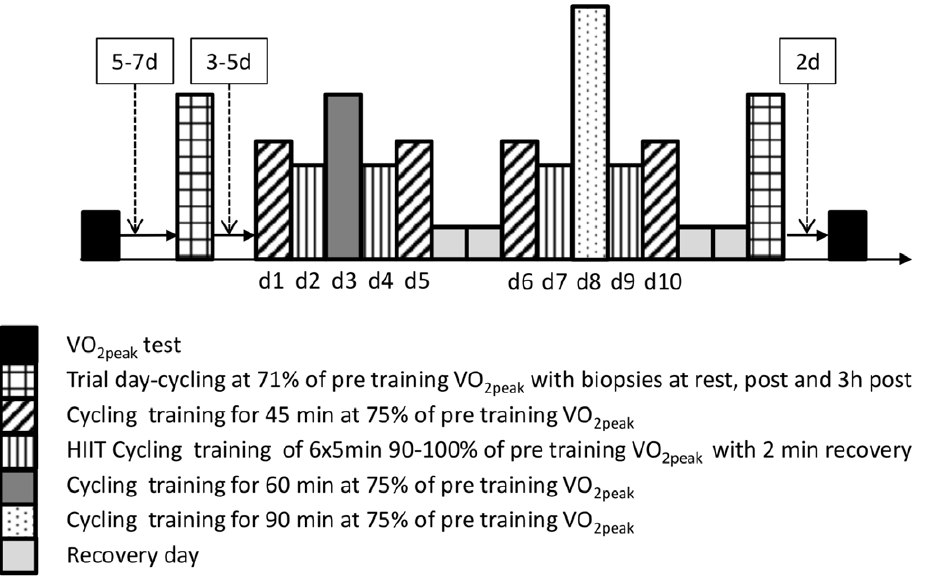
Figure 1. Schema of the study design showing the 4 testing and 10 training sessions undertaken by each participant. D-day; HIIT- High-intensity interval-training; VO 2peak -maximal oxygen consumption.